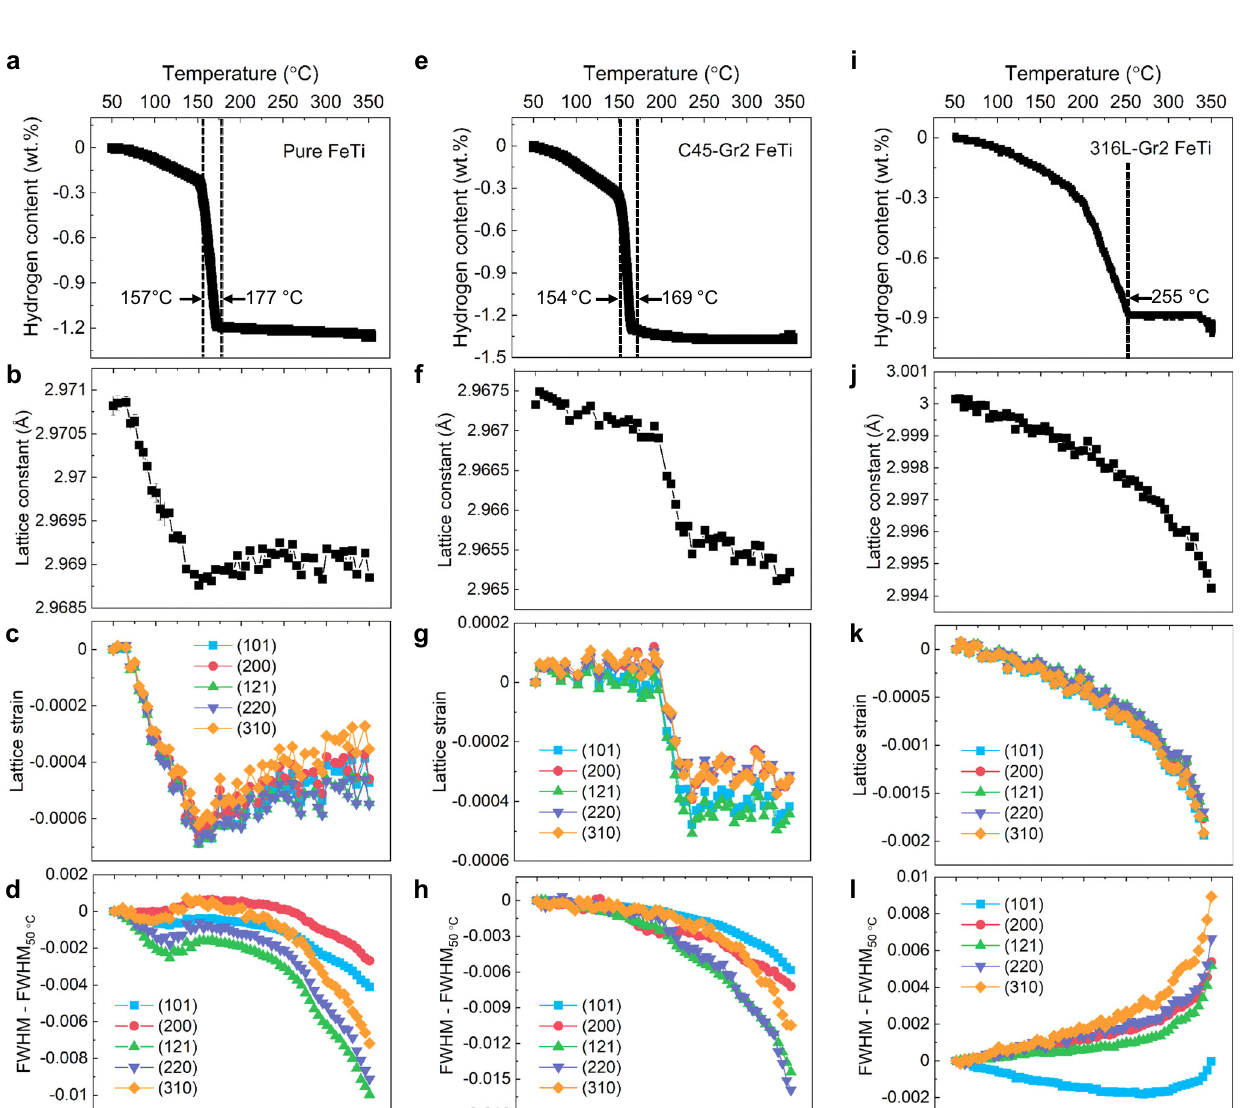
Fig. 4 Dehydrogenation behaviors and corresponding in-situ SR-PXD ( λ = 0.20734Å) results of pure FeTi, C45-Gr2 FeTi, and 316L-Gr2 FeTi alloys. Backpressure for pure FeTi and C45-Gr2 FeTi is 40 bar, and for 316L-Gr2 FeTi is 10 bar. a Volumetric hydrogen capacity, and corresponding, b lattice constant, c lattice strain, and d FWHM changes during in-situ SR-PXD measurements for the pure FeTi powders. e volumetric hydrogen capacity, and corresponding f lattice constant, g lattice strain, and h FWHM changes during in situ SR-PXD measurements for the C45-Gr2 FeTi powders. i volumetric hydrogen capacity, and corresponding j lattice constant, k lattice strain, and l FWHM changes during in-situ SR-PXD measurements for the 316L-Gr2